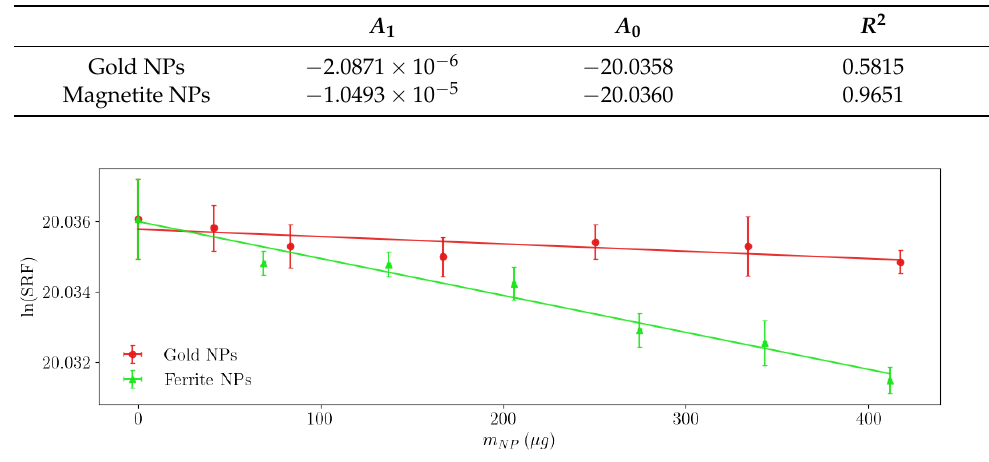
Figure 10. Measurements with the experimental setup (symbols) and model adjustment